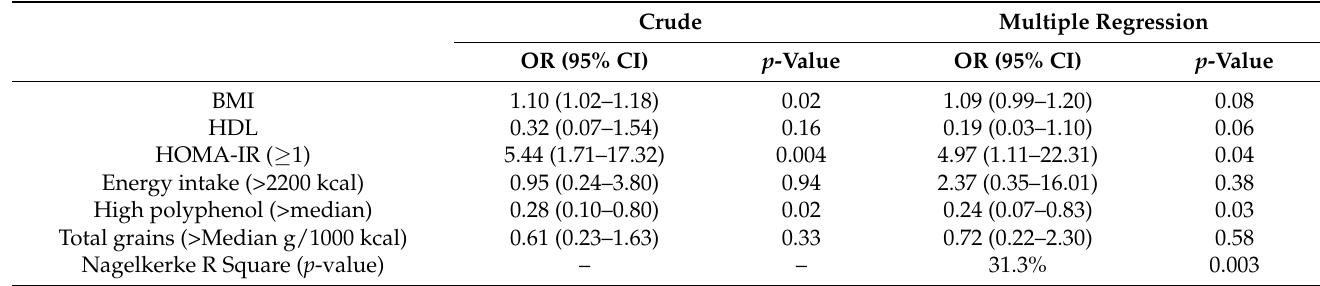
Table 3. Association between different nutritional biomarkers or factors and poor sleep status. Crude Multiple